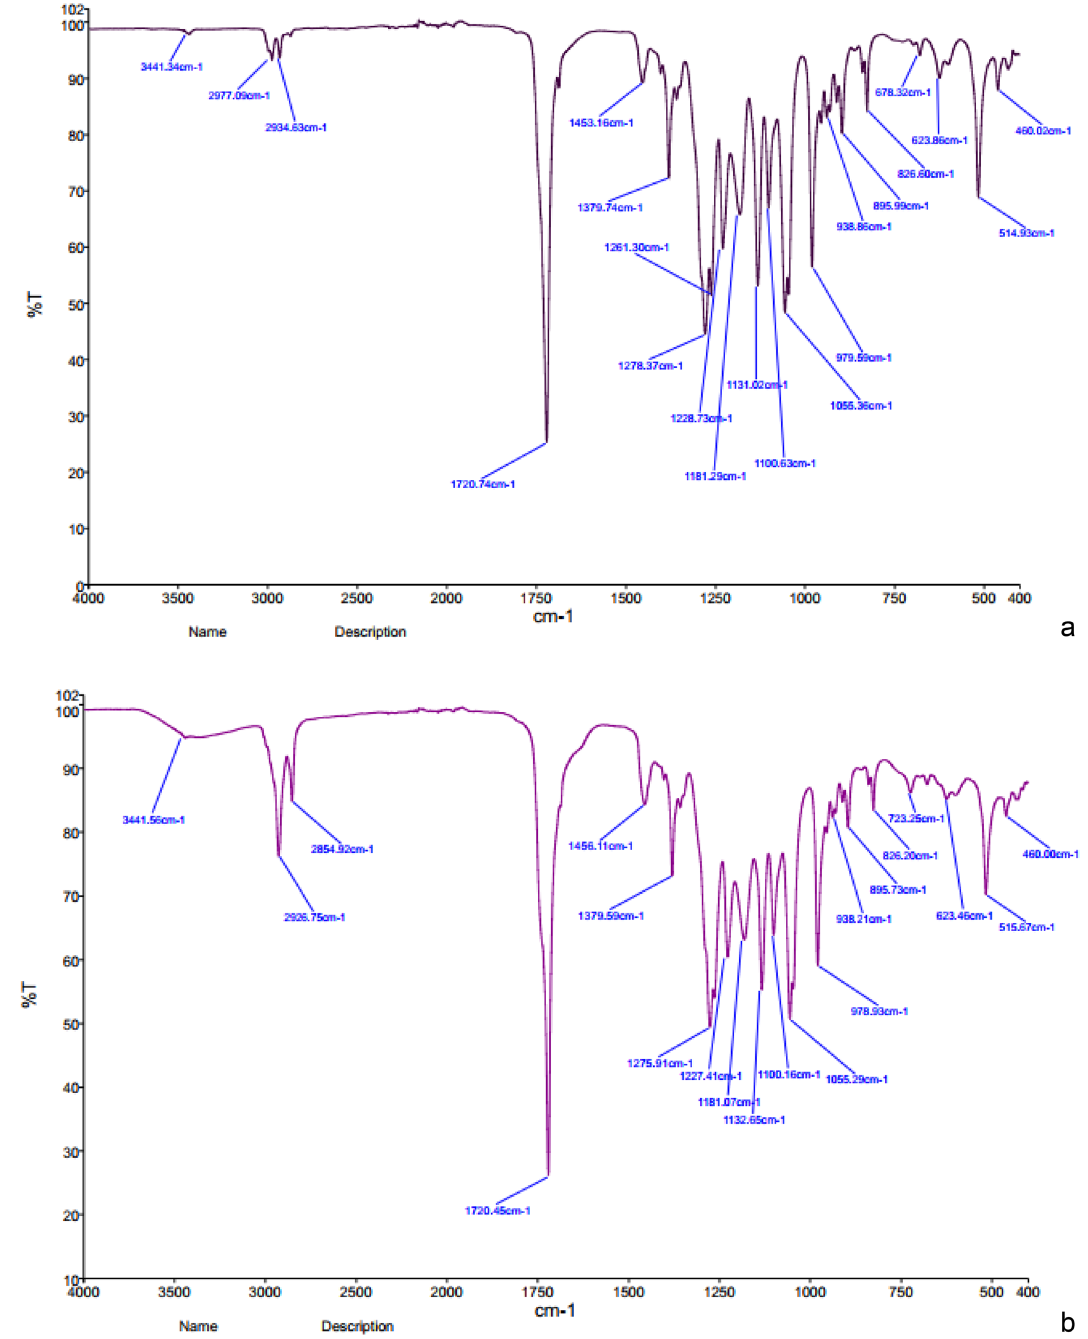
Figure 2. ( a ), FTIR spectrometer of PHA standard; ( b ), PHA produced by Pichia sp. TSLS24; ( c ), HNMR analysis of PHA standard (Sigma); ( d ) PHA produced by Pichia sp. TSLS24; ( e ), GC-MSn analysis of PHA standard (Sigma); ( f ) PHA produced by Pichia sp. TSLS24; ( g ), mass spectra of accumulated PHA by TSLS24; ( h ), Crotonic standard line for PHA